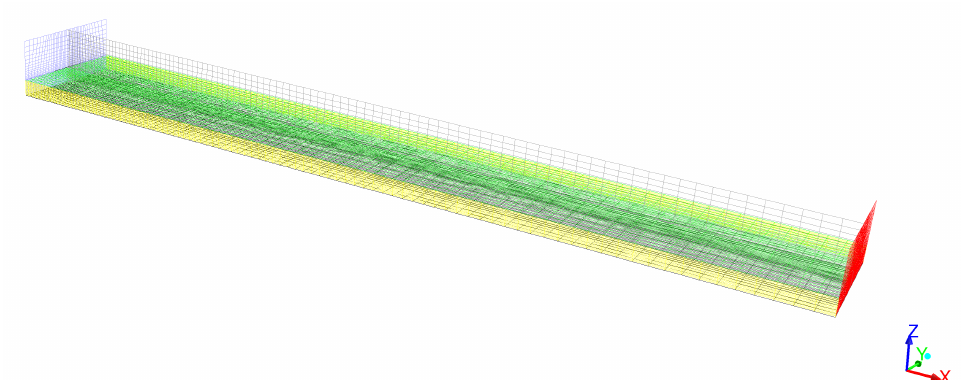
Figure 2. Geometry of the computational domain, including the culvert pipe opening in the form of a slot located near the bottom on the left. The gray color shows the plane section of the computational domain (plane y = 15 m). The green color indicates the boundary between the composite and porous media. The outlet of the computational domain is shown in red. The location of the porous medium is shown in